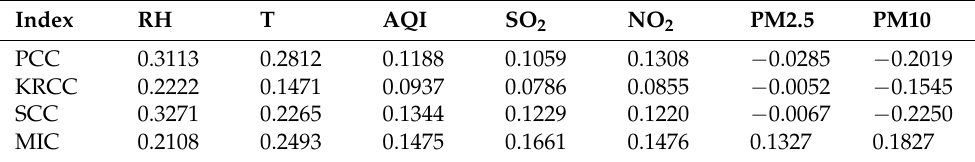
Table 4. Statistical correlations of atmospheric factors and corrosion rate in Stage 2.